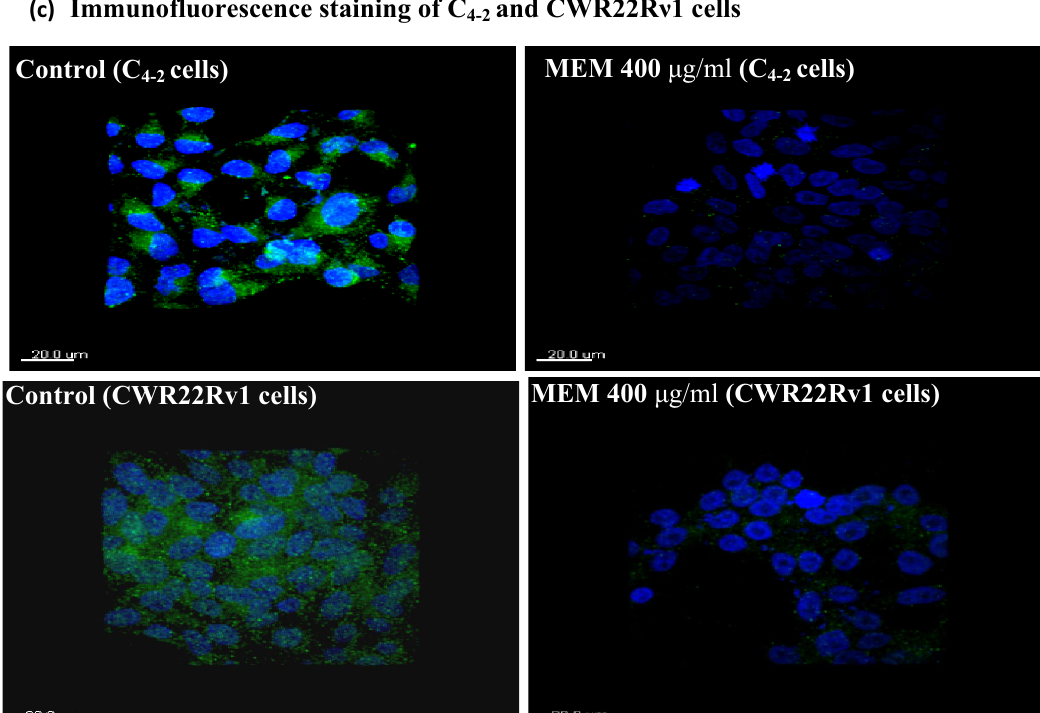
Figure 5 . Validation of TPD52 expression in C 4-2 and CWR22Rν1 cells and effect of MEM treatment on TPD52 expression in both cell lines. ( a ) Immunoblot analysis of TPD52 expression of C 4-2 and CWR22Rν1 in MEM treated group as compared to the control group. The total cell lysate was prepared and 40 μg protein was subjected to SDS-page followed by Immunoblot analysis and chemiluminescence detection. Equal loading of protein was confirmed by stripping the immunoblot and reprobing it for β-actin, the experiment was done in triplicate. ( b ) Modulation of TPD52 expression by MEM treatment in CWR22Rν1 (b1) and C 4-2 (b2) cells. mRNA expression of TPD52 in MEM treated CWR22Rν1 and C 4-2 cells (RT-PCR), experiment performed in triplicate (mean ± SD), *, p < 0.01, **, p < 0.05. ( c ) Immunofluorescence staining of C 4-2 and CWR22Rν1 cells demonstrating expression of TPD52 in both MEM treated (40 mol/L) of C 4-2 (c2) and CWR22Rν1 (c4) cells as compared to control C 4-2 (c1) and CWR22Rν1 (c3) cells (untreated). Alexa fluor staining of TPD52 of both cell lines (green fluorescence) and counterstained with DAPI (blue fluorescence) were